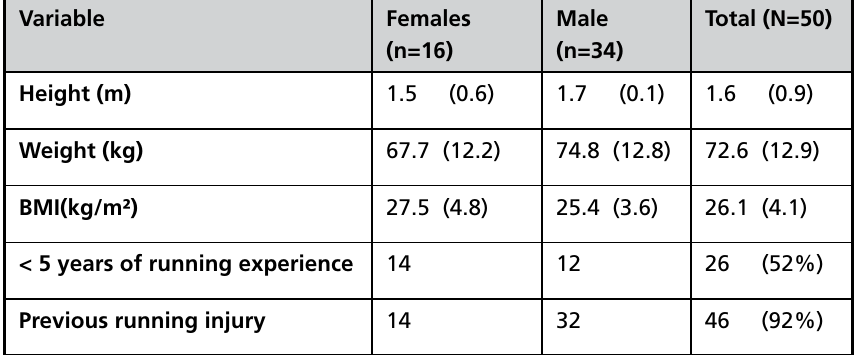
table 1: Baseline measurements of the participants (n=50) Mean (sD)